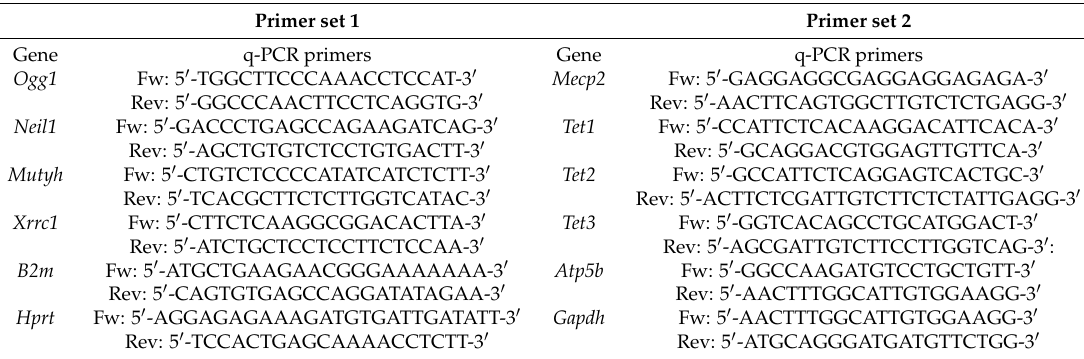
Table 2. Overview qPCR primers to study gene